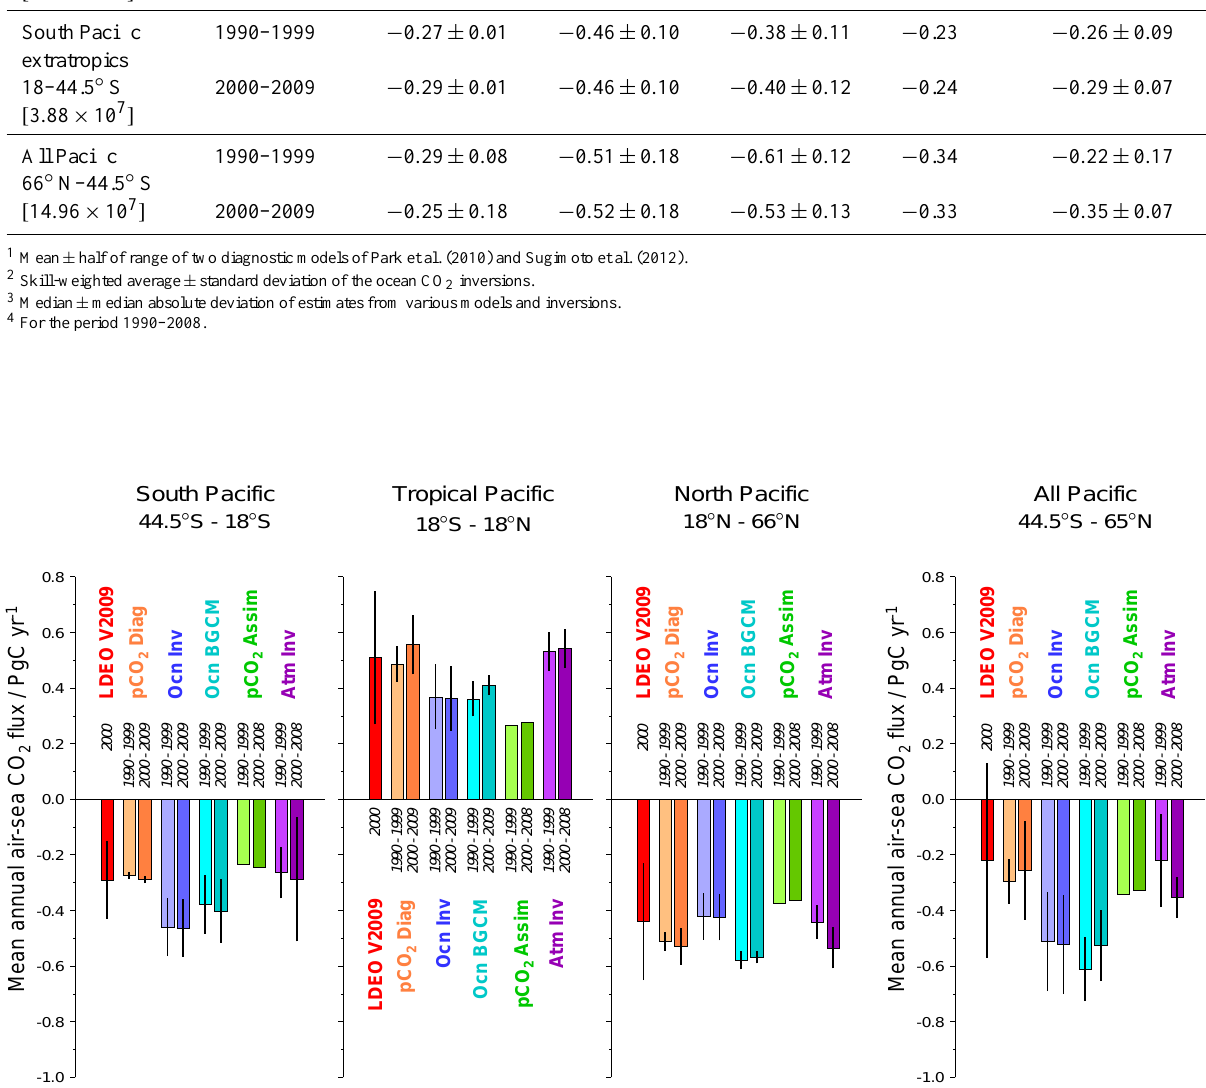
Fig. A1. Summary of regionally integrated and time-averaged net air–sea CO 2 flux (PgCyr − 1 ) for 1990–1999 and 2000–2009 in the Pacific Ocean regions shown in Fig.